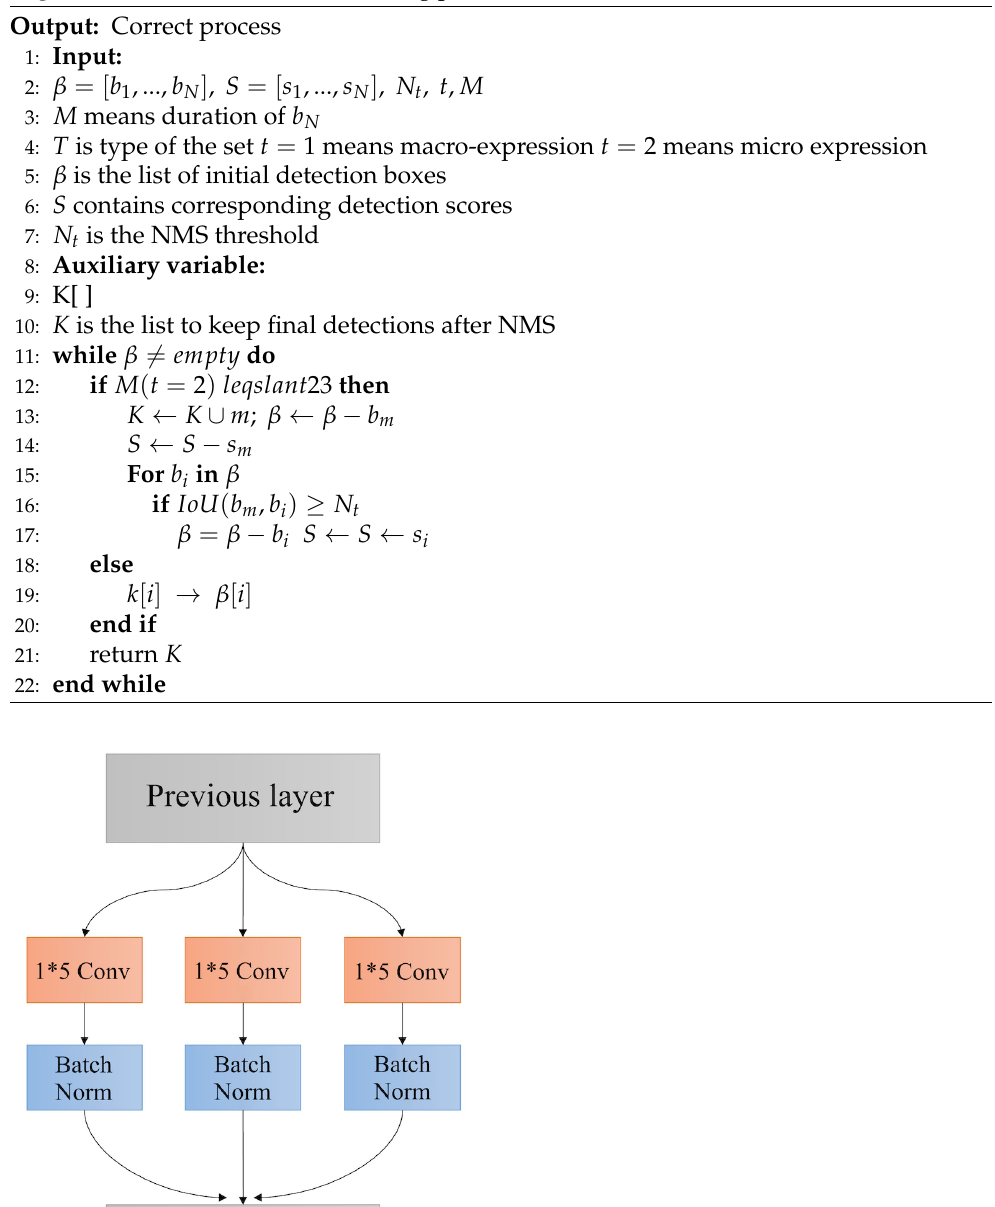
Algorithm 1 ME-NMS loss calculating procedure.